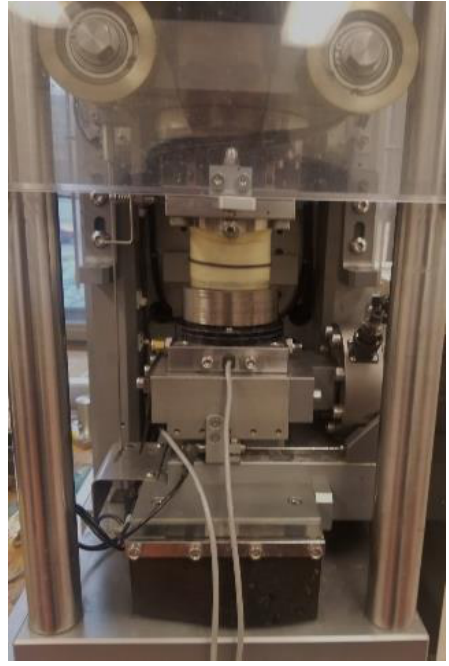
Figure 3. A DSS specimen mounted for testing.